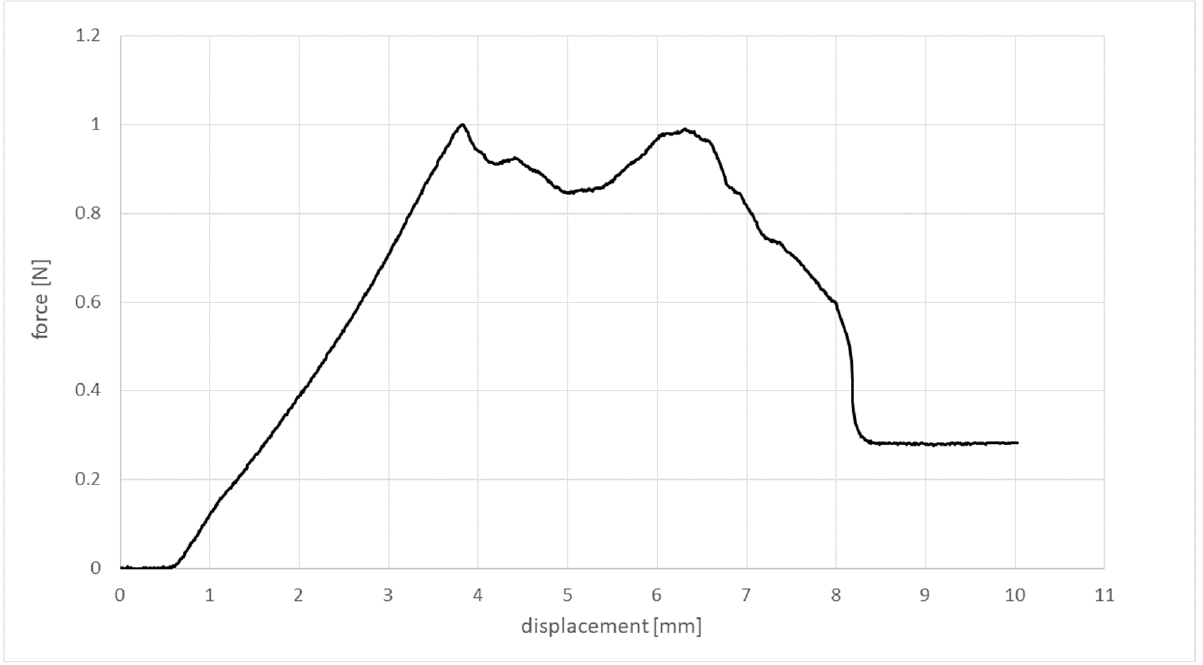
Figure 7. Force displacement diagram of one sample penetration at 90° without prestress. The force is presented in Newton and the displacement is presented in millimeters.